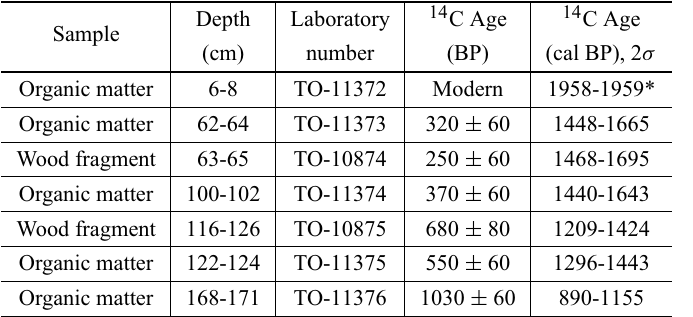
TABLE II 14 C ages of organic matter obtained in the Lagoa Grande